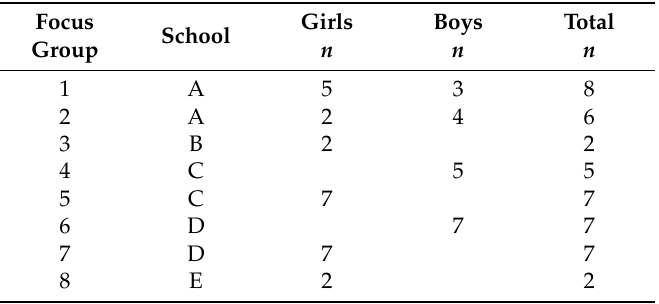
Table 1. Overview of the focus